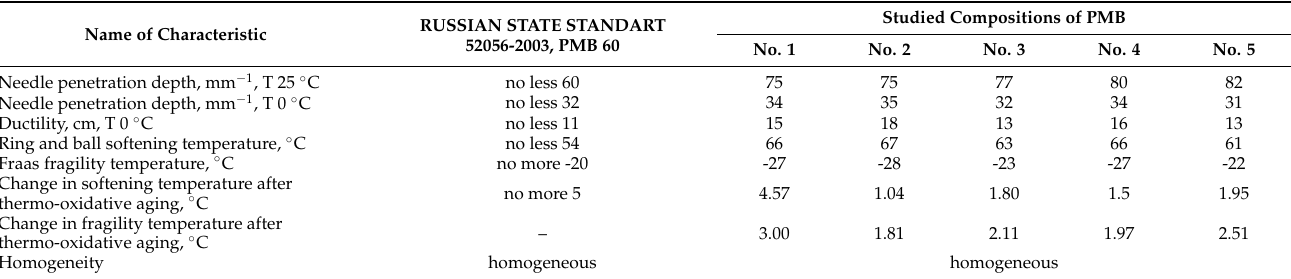
Table 6. Physical and mechanical characteristics of polymer-modified binder (PMB).